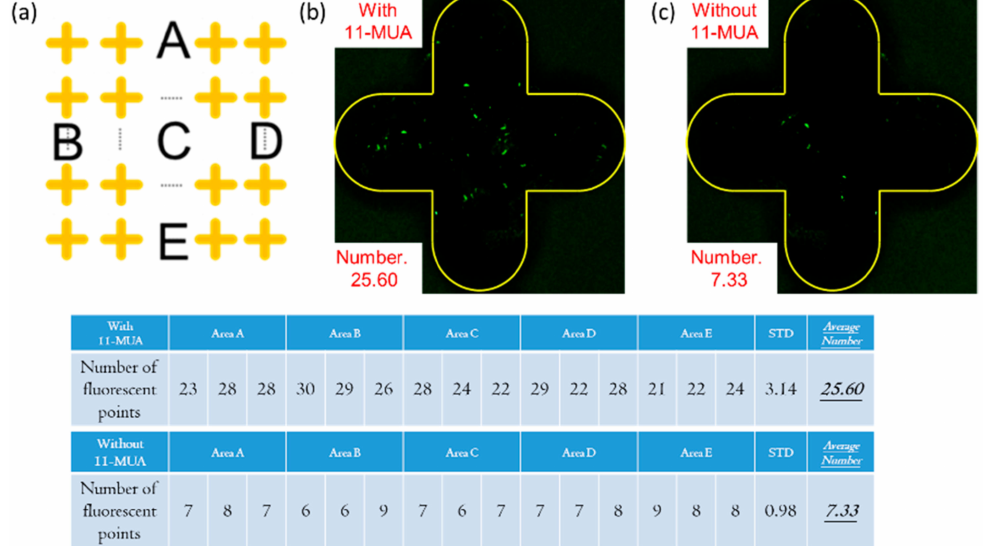
Figure 4. ( a ) Five regions on the top, left, middle, right, and bottom of the metamaterial array; ( b , c ) the average number of fluorescent dots results, with and without 11-MUA. Figure 4b,c are the fluorescence results of the comparison with and without